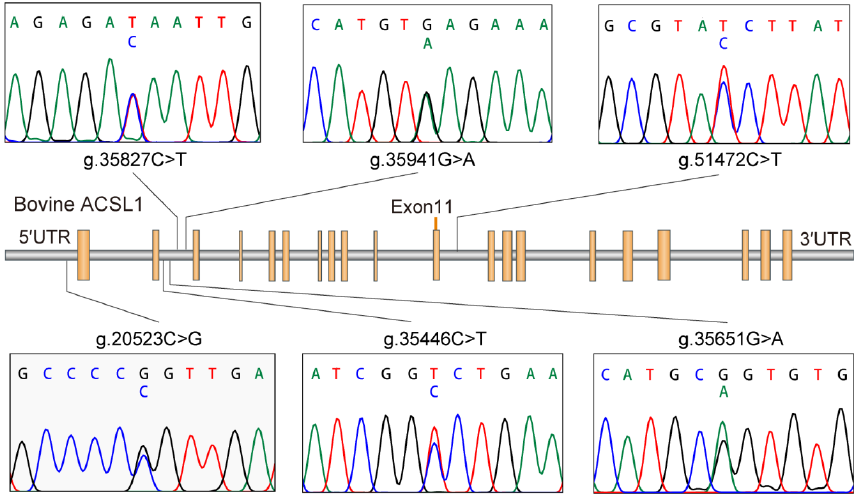
Figure 1. Long-chain acyl-CoA synthetase 1 gene ( ACSL1 ) with the localization of the six identified single nucleotide polymorphisms (SNPs).